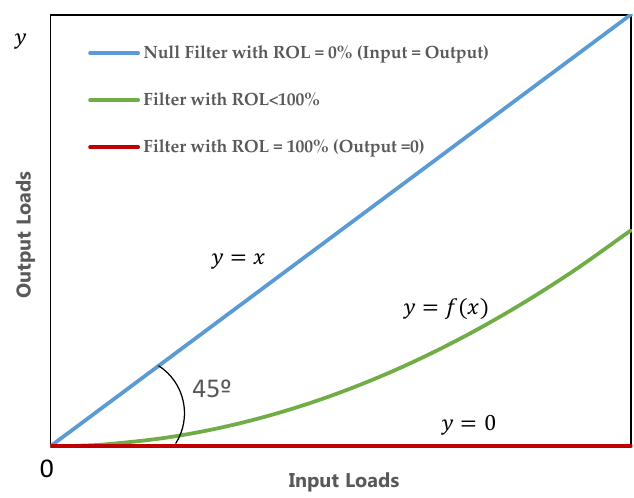
Figure 5. Regression of Loads for Filters with ROL = 0 to 100%.